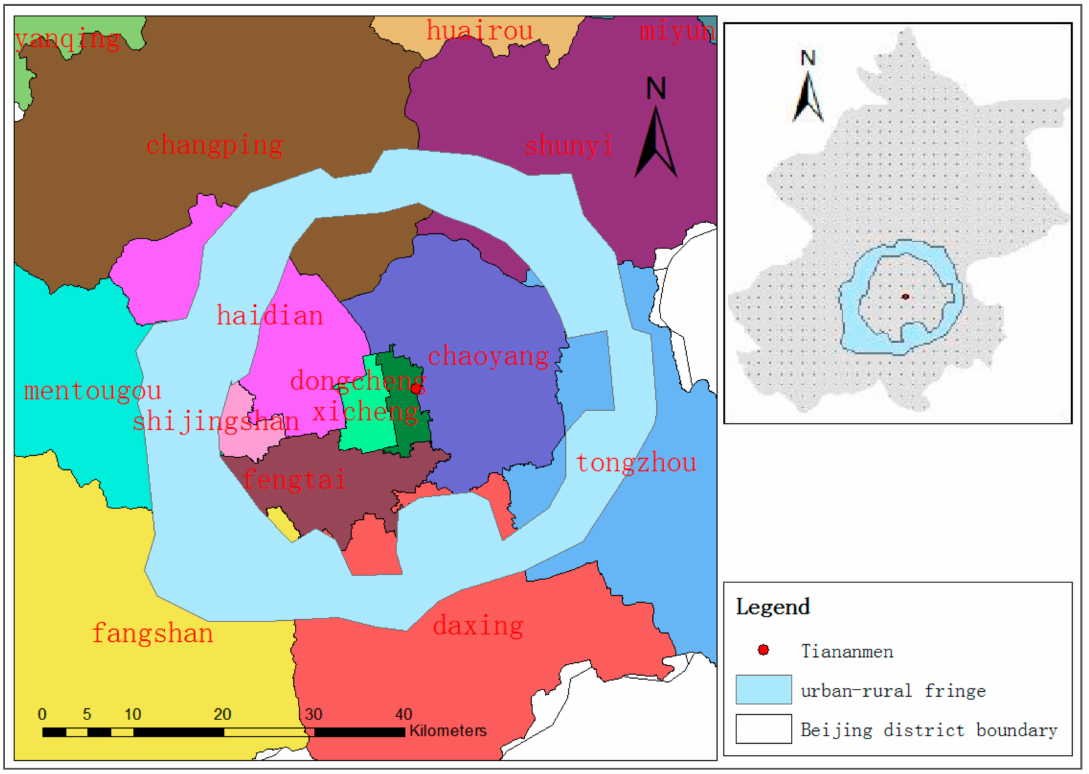
Figure 8. Territorial scope of the urban-rural fringe area in